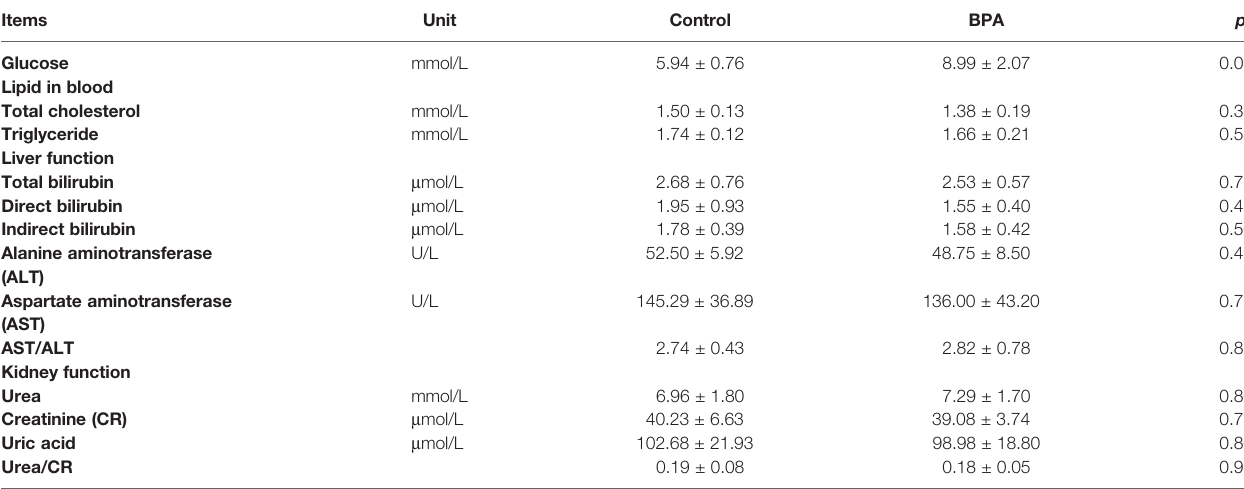
TABLE 4 | Effect of BPA on the biochemical parameters in rats.